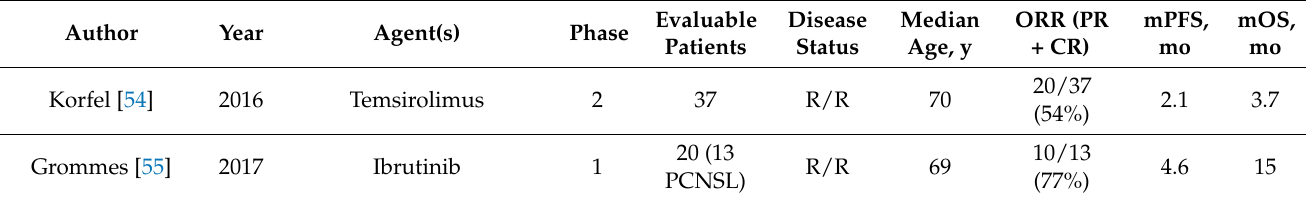
Table 1. Recent prospective trials of novel